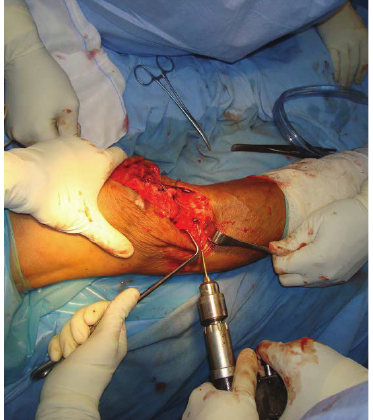
Figure 2: Showing fibre mesh wire placed across patellar tendon (Krackow method).